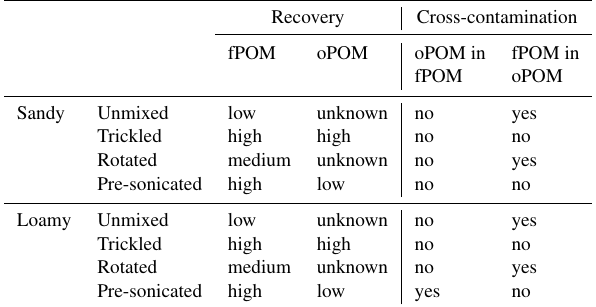
Table 3. Performance of the four different approaches (unmixed, trickling, rotation and pre-sonication). oPOM recovery is called un- known, if the oPOM fraction is contaminated with fPOM